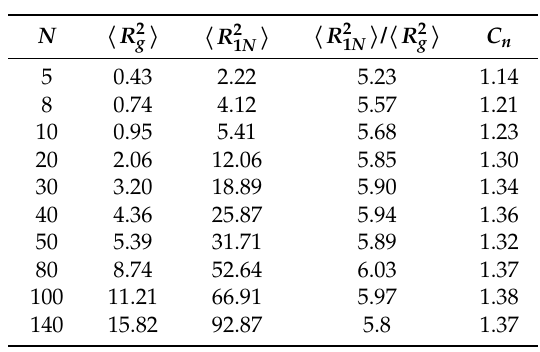
Table 1. Structural properties of dilute polymer solutions in the theta solvent condition. The mean-square (cid:68) (cid:69) R 2 g radius of gyration and mean-square end-to-end distance all chains in the system for each frame, and then averaged over 5000 frames with a separation of 1 τ between consecutive